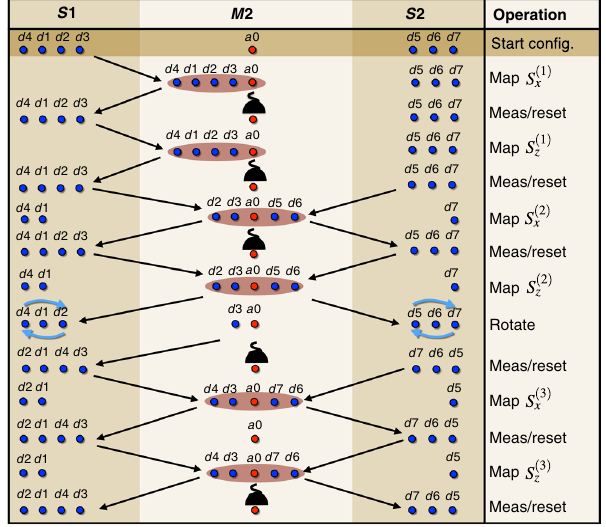
FIG. 15. Real-space representation of shuttling-based one- species QEC cycle with multiqubit MS gates: Data and ancillary ions are represented by blue and red dots, respectively, and are distributed within the storage and manipulation regions of the first row. The black arrows pointing to the storage zone represent splitting operations followed by a shuttling of a subset of physical ions onto the processing zone, after which they all merge with the static ancillary ion. The black arrows towards the storage zones represent splitting operations, followed by a shuttling of the physical ions back to the storage zone, where they are merged with any physical ions that might already be present there. The blue arrows within the storage zone represent crystal rotations that reorder the physical ions. On the right column, we specify the times where the stabilizer mappings Map S ð m Þ α , implemented by multiqubit entangling gates and represented by red ellipses, and ancillary measurements or reset (Meas or reset), represented by a black detector, are